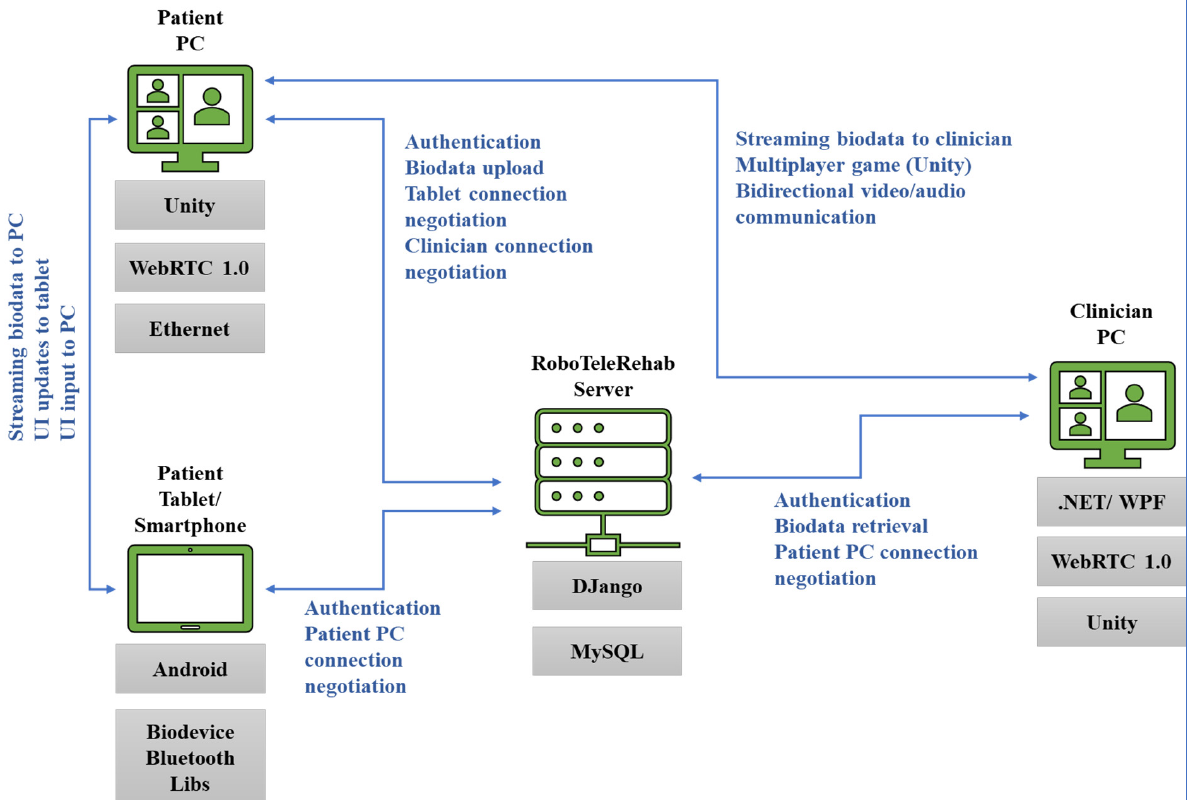
Figure 2. RoboTeleRehab system dataflow.